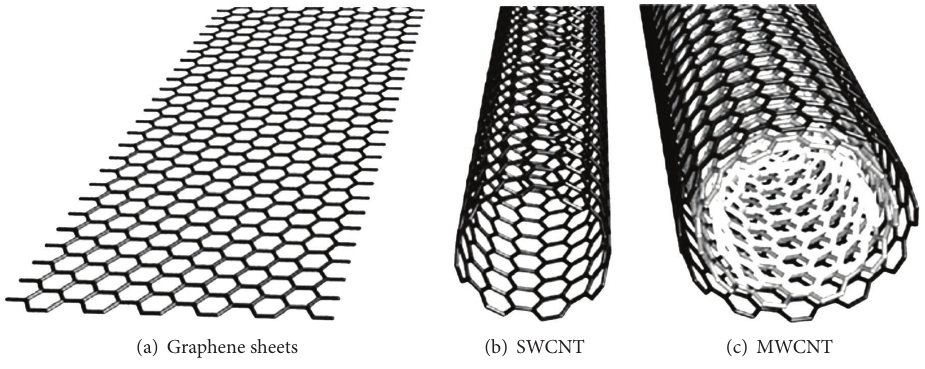
Figure 1: Graphene versus carbon nanotubes [31].